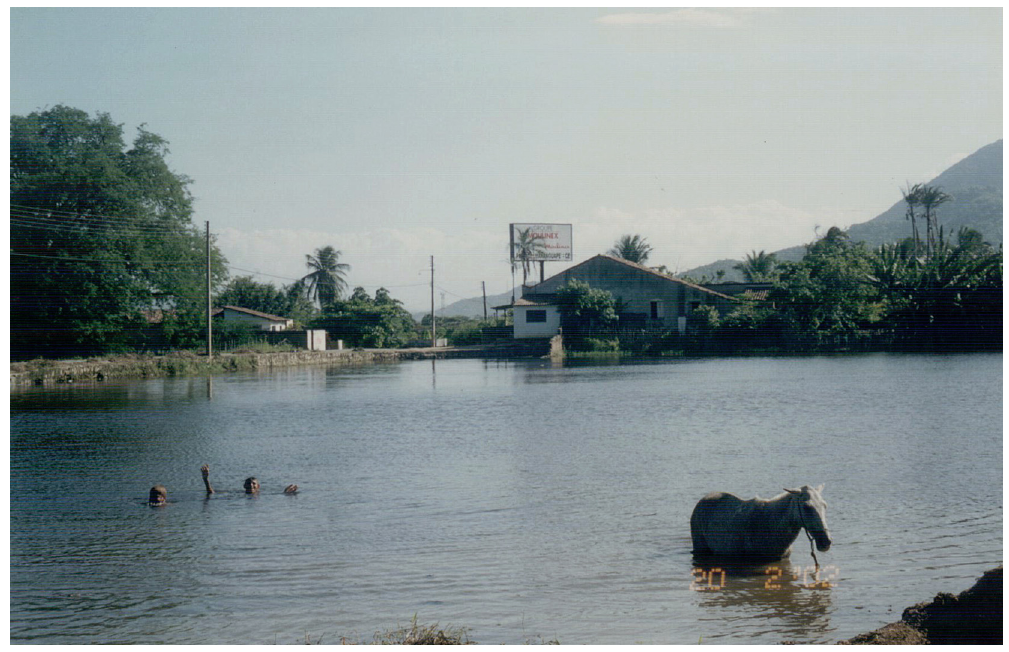
Figure 1. The Vavaú Reservoir, next to the electrical appliances factory, heavily used by the neighborhood community for several purposes. (Photo by the author)